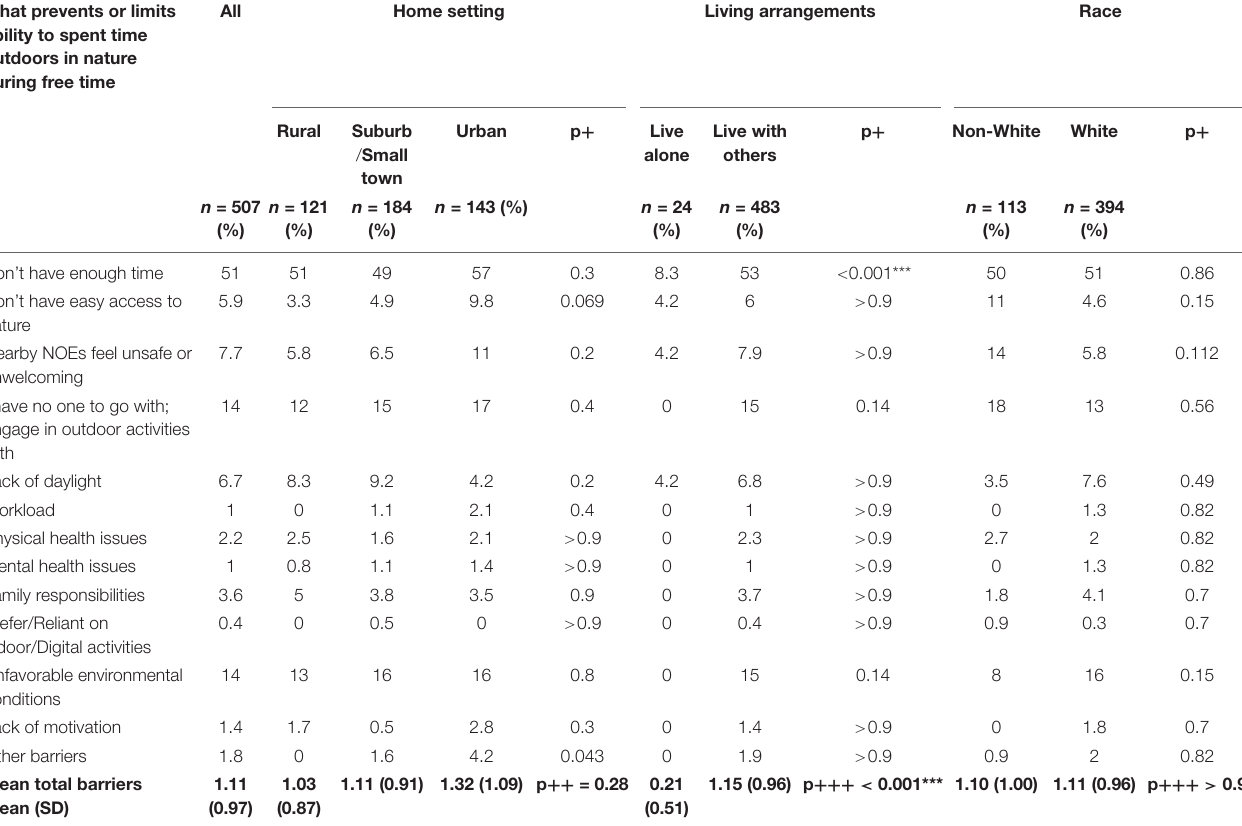
TABLE 9 | Differences in barriers to accessing NOEs for all participants and home setting, living arrangement and racial subgroups. What prevents or limits All Home setting Living arrangements Race ability to spent time outdoors in nature during free time